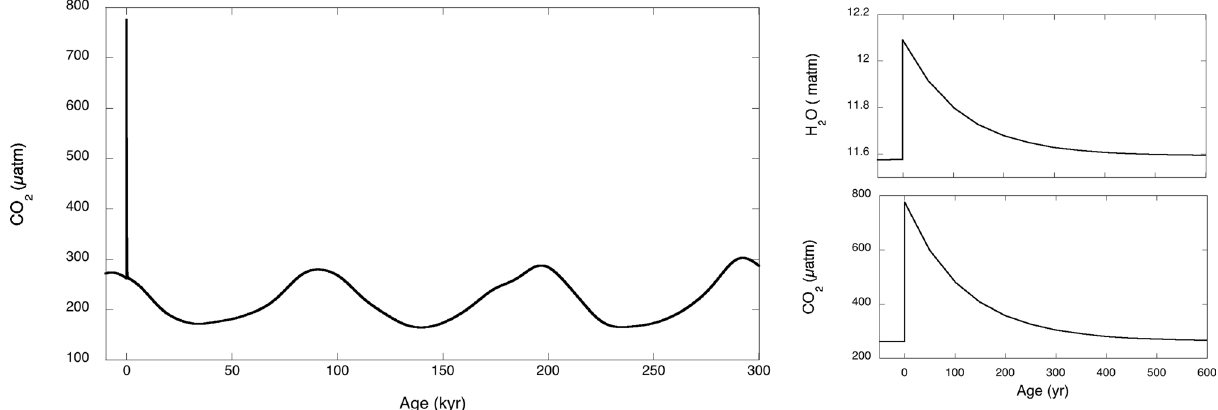
Figure 9. Predicted changes in the CO 2 and water vapor after a CO 2 pulse of 1,000